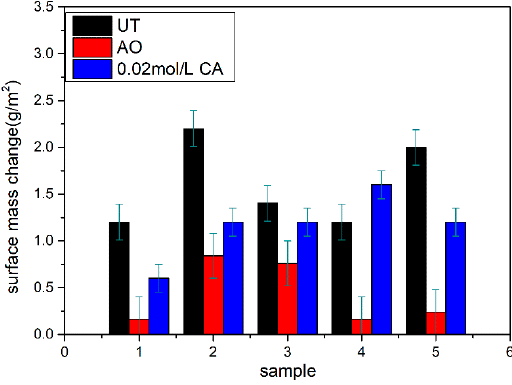
Figure 9. Surface mass change in the sample.